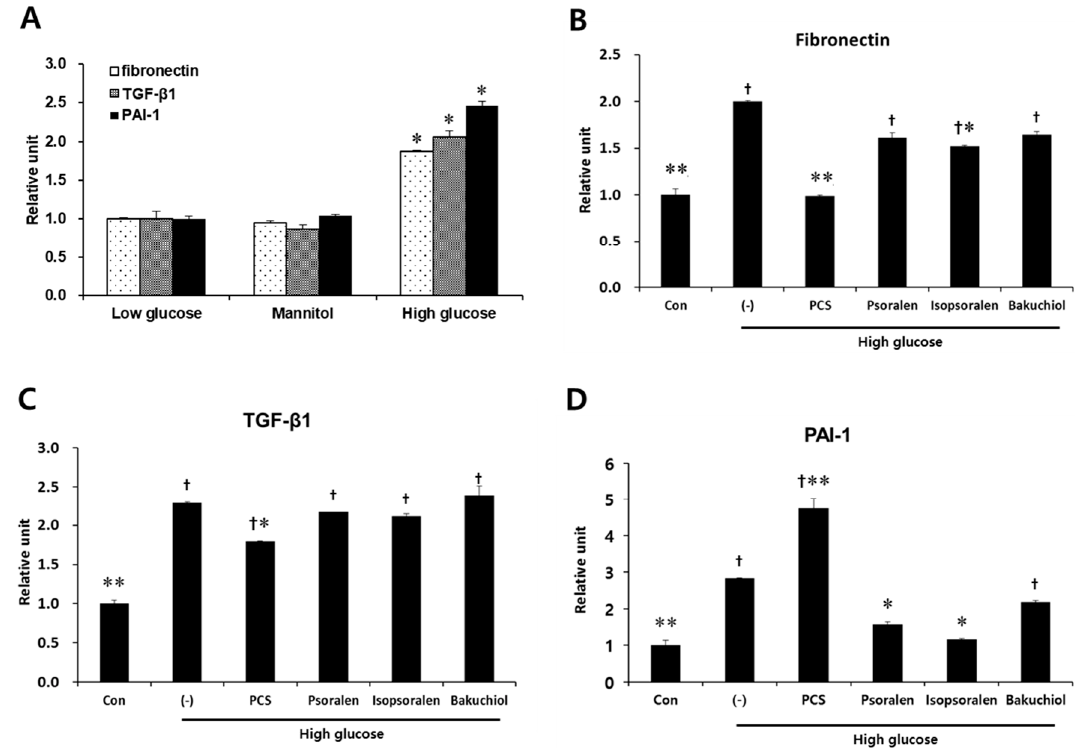
Figure 5. Effect of PCS extract and its components on fibrosis-related gene expression in high glucose- treated mesangial cells. ( A ) SV40 MES13 cells maintained in low glucose (5.5 mM), glucose (5.5 mM) and mannitol (19.4 mM), or high glucose (25 mM) for 72 h. Total RNA was extracted and qRT-PCR analysis was performed. *, p < 0.05 vs. Low glucose. ( B – D ) SV40 MES-13 cells were treated as described in Figure 4B–F. After 72 h, total RNA was extracted and qRT-PCR analysis was performed for: ( A ) fibronectin; ( B ) PAI-1; and ( C ) TGF- β 1. The mRNA levels were normalized with those of